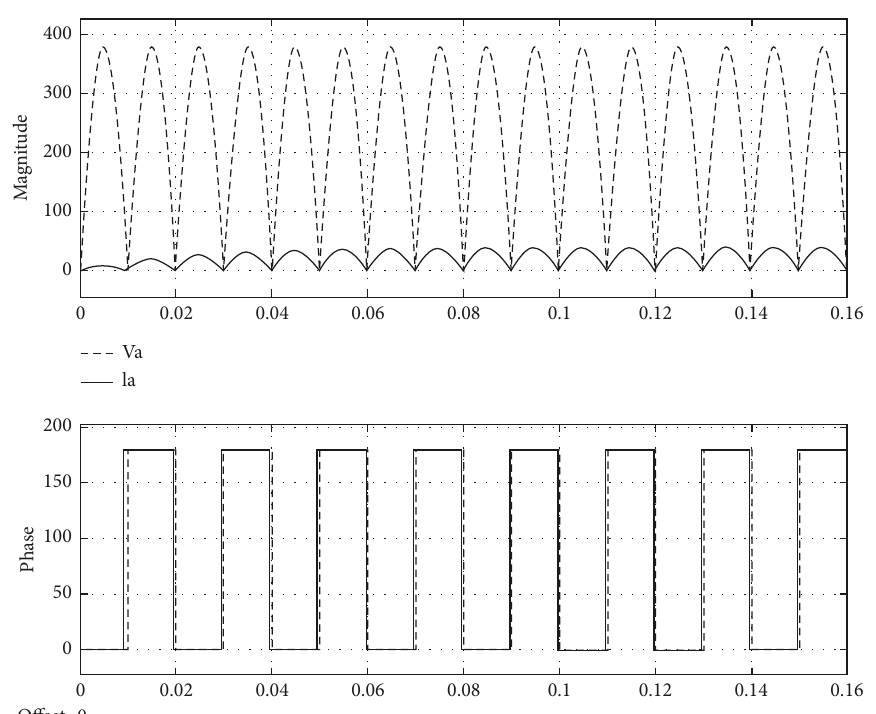
Figure 11: Input voltage and current waveform in amplitude-phase pattern when the conduction angle of H-bridge is 0.